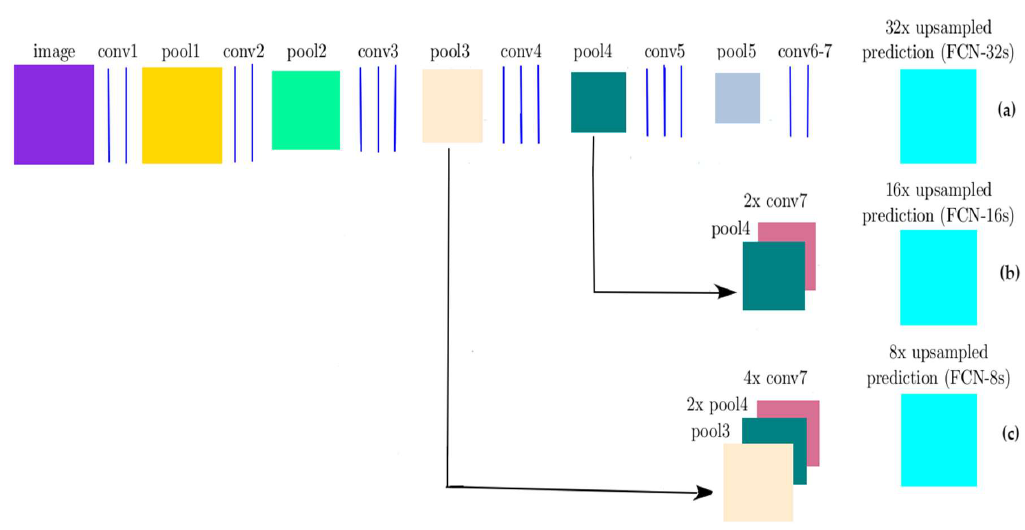
Figure 2. FCN architecture: ( a ) FCN with an output stride 32 (FCN-32s); ( b ) FCN with an output stride of 16 (FCN-16s); ( c ) FCN with an output stride of 8 (FCN-8s) [19].